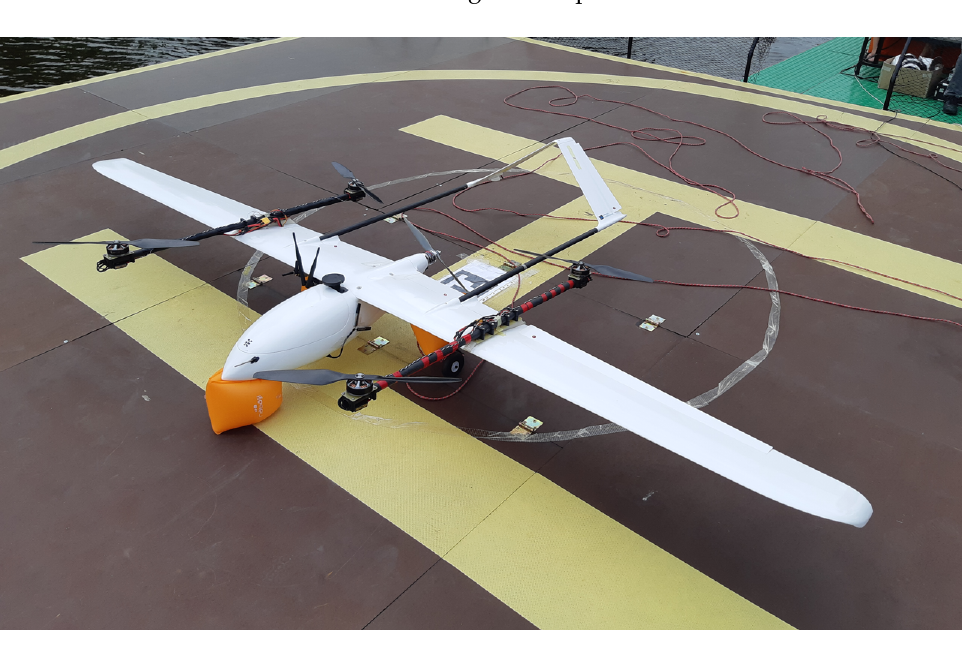
Figure 2. The Albatross VTOL